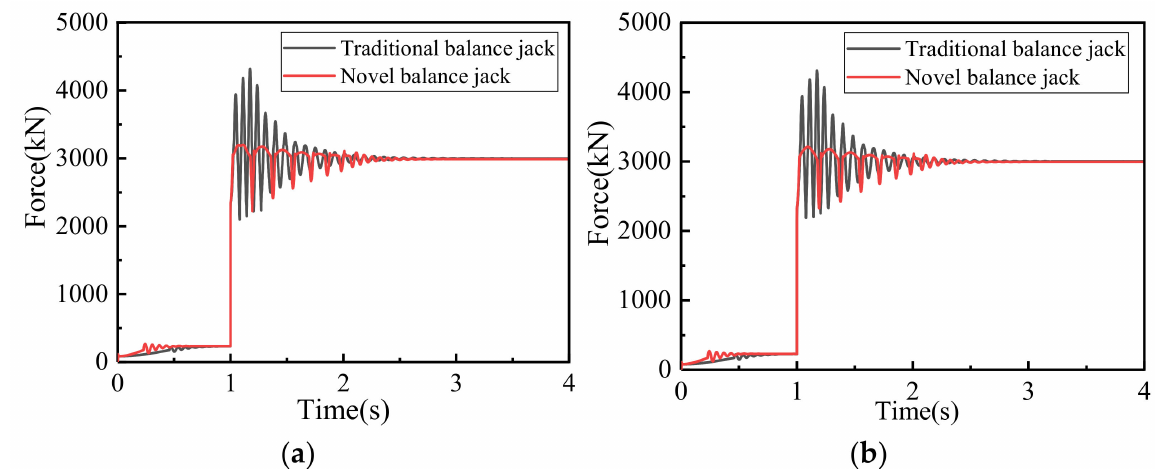
Figure 8. Force at hinge point: ( a ) The hinge point of top beam-balance jack. ( b ) Hinge point of shield beam-balance